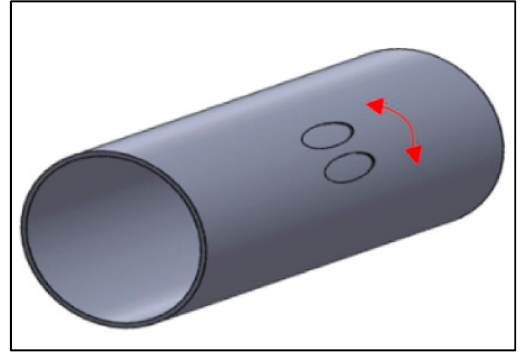
Figure 2. Circumferential interacting defects [15].